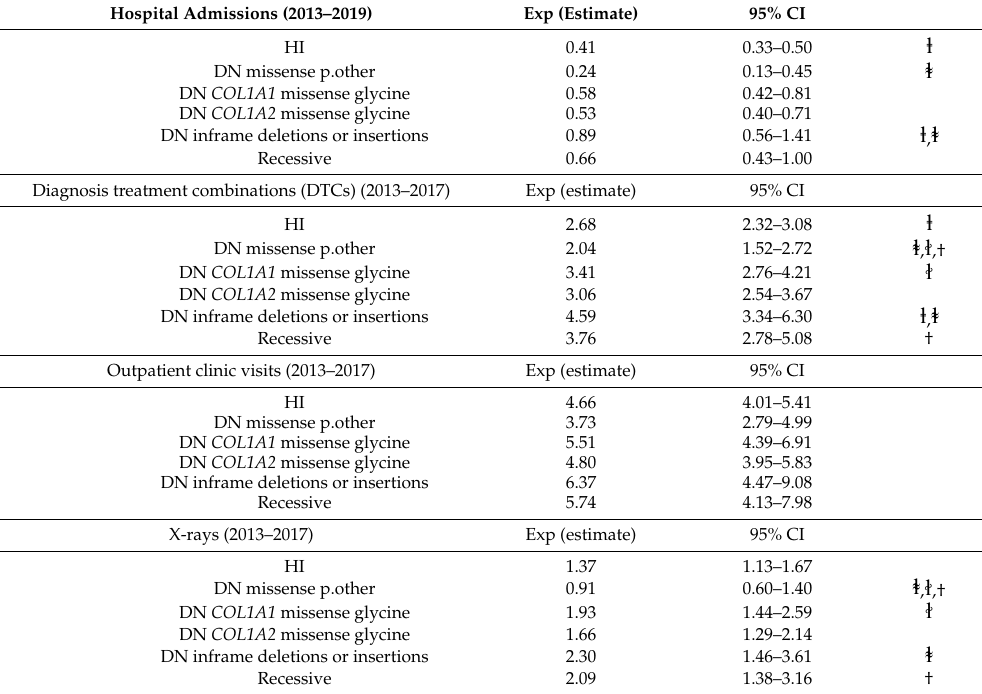
Table 3. The average number of units of medical care used per year for different genetic groups of the Dutch OI cohort